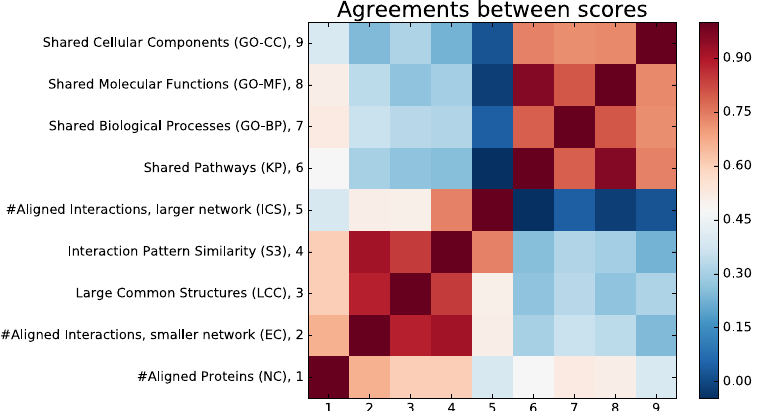
Figure 1. Relationships between alignment scores. The heat-map presents the agreements between the alignments scores, measured by their Pearson’s correlation coefficients (PCCs), which we computed over all alignments produced by all aligners. High PPC values (red) highlight the scores that are in good agreements, while low PCC values (blue) highlight the scores that have no